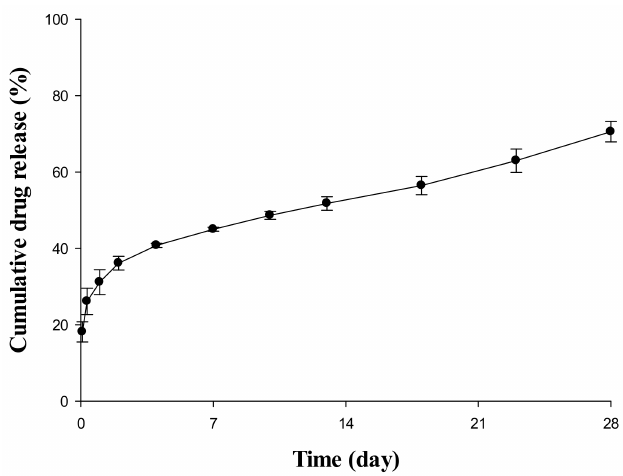
Figure 1. In vitro release profile of SR depot for 28 days in pH 6.8 phosphate-buffered saline (PBS) containing 0.02% Tween 80.